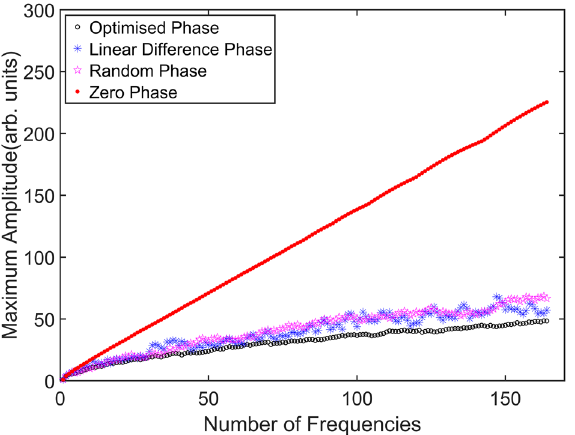
Figure 1. Comparison of different phase design approaches for the minimization of the maximum signal amplitude. All the prime numbers in the range [10,1000] were used as driving